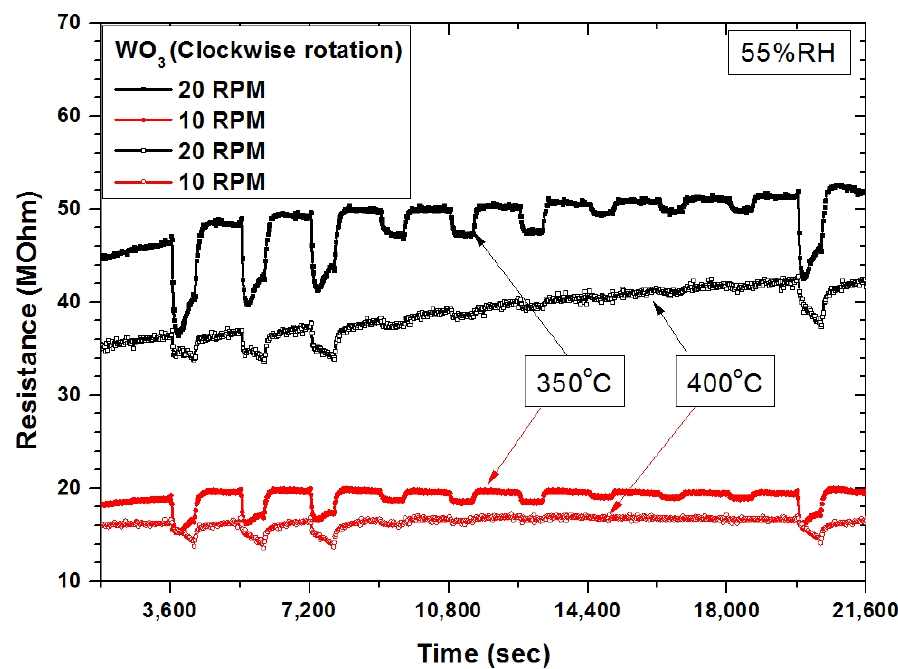
Figure 18. The gas-sensing characteristics of WO 3 -based gas sensor deposited with various rotations with stabilization, under exposure to acetone in the range of 2.5–20 ppm, at 350 °C/400 °C and 55% RH.